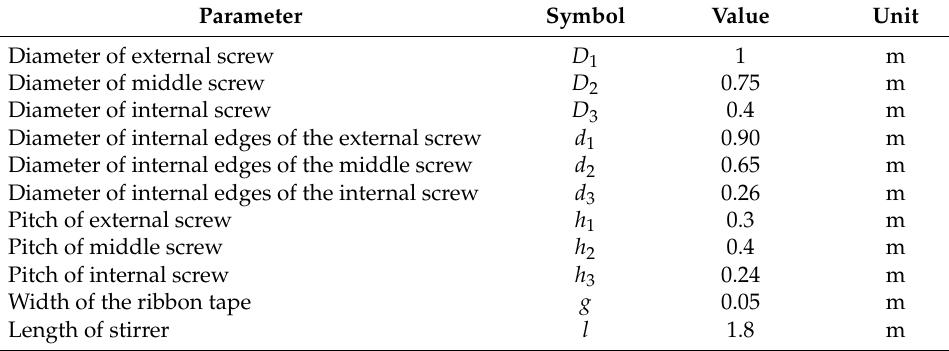
Figure 3. The stirrer of a screw mixer: ( a ) general view; ( b ) scheme: D 1 —diameter of external screw; D 2 —diameter of middle screw; D 3 —diameter of internal screw; h 1 —pitch of external screw; h 2 —pitch of middle screw; h 3 —pitch of internal screw. Table 1. Parameters of the stirrer used in a screw mixer.